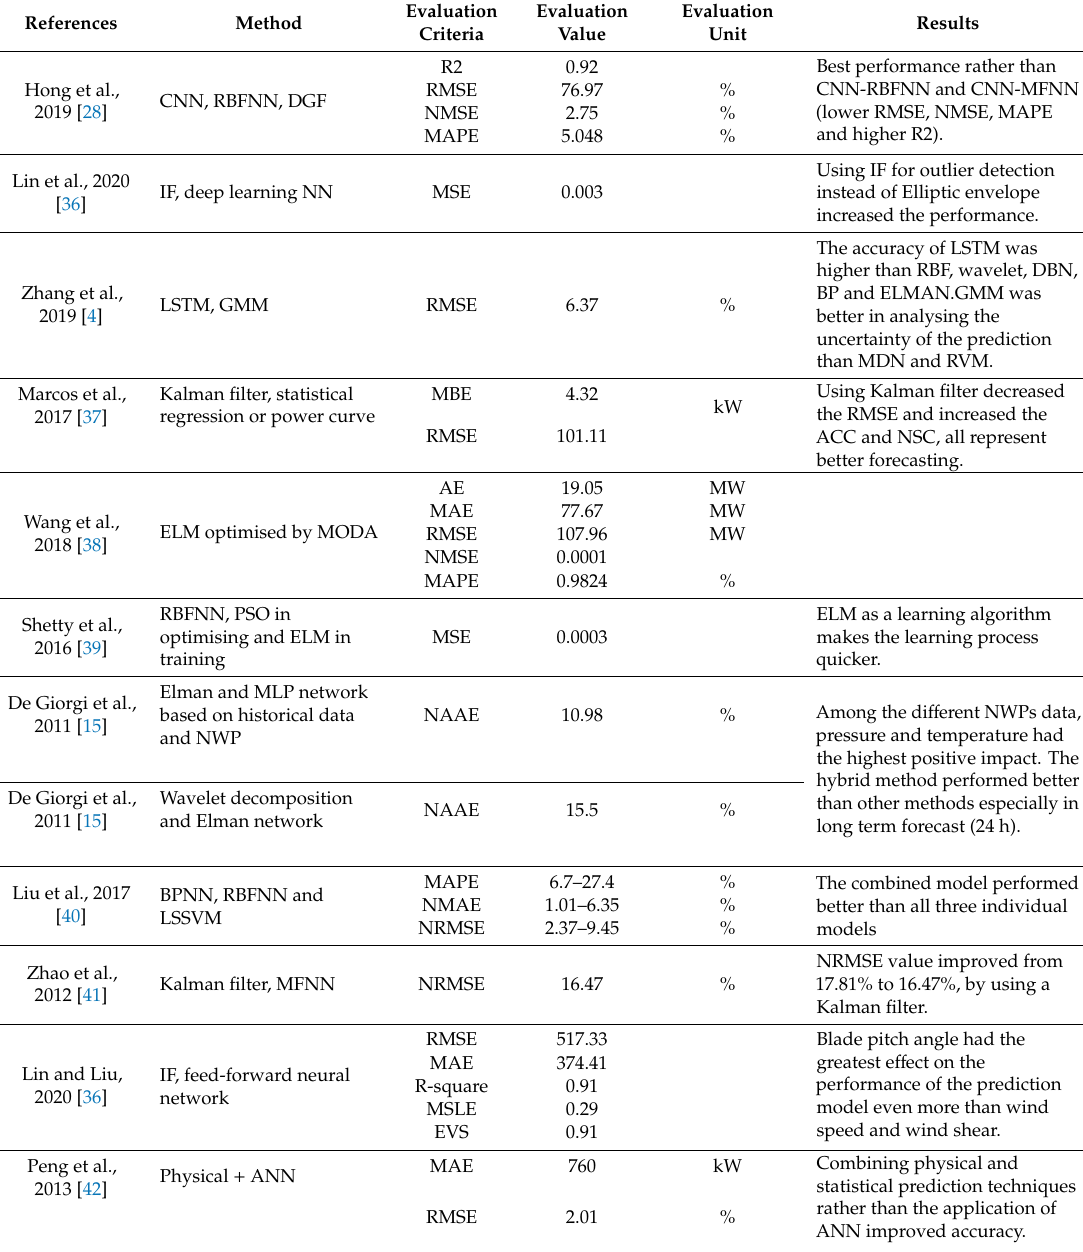
Table 7. Performance evaluation in hybrid wind power prediction